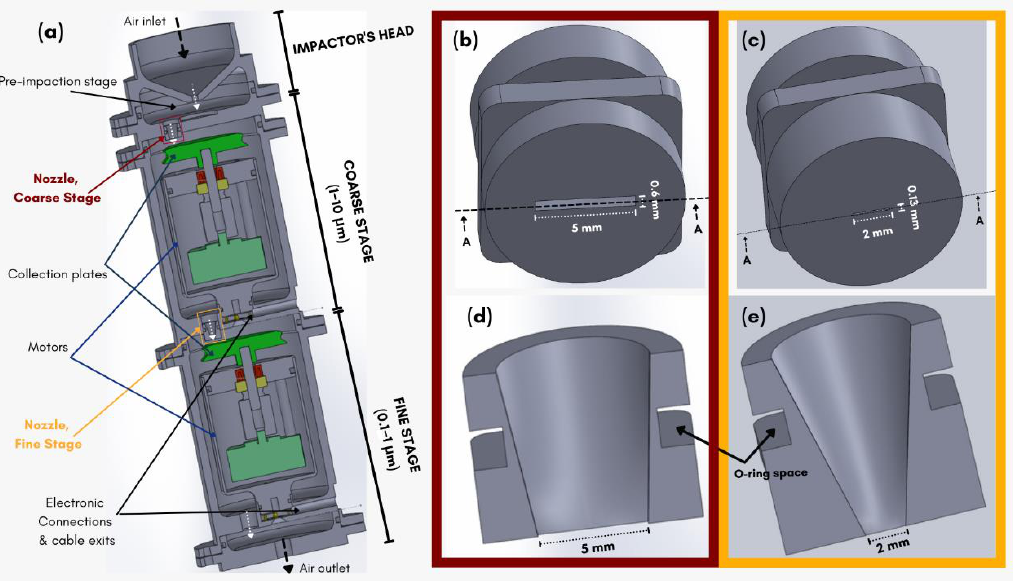
Figure 1. Internal view of the TRAPS impactor ( a ) and scheme of the acceleration nozzles with their dimensions and internal views (A-A cross-sectional drawing), for the coarse ( b , d ) and fine ( c , e ) stages.